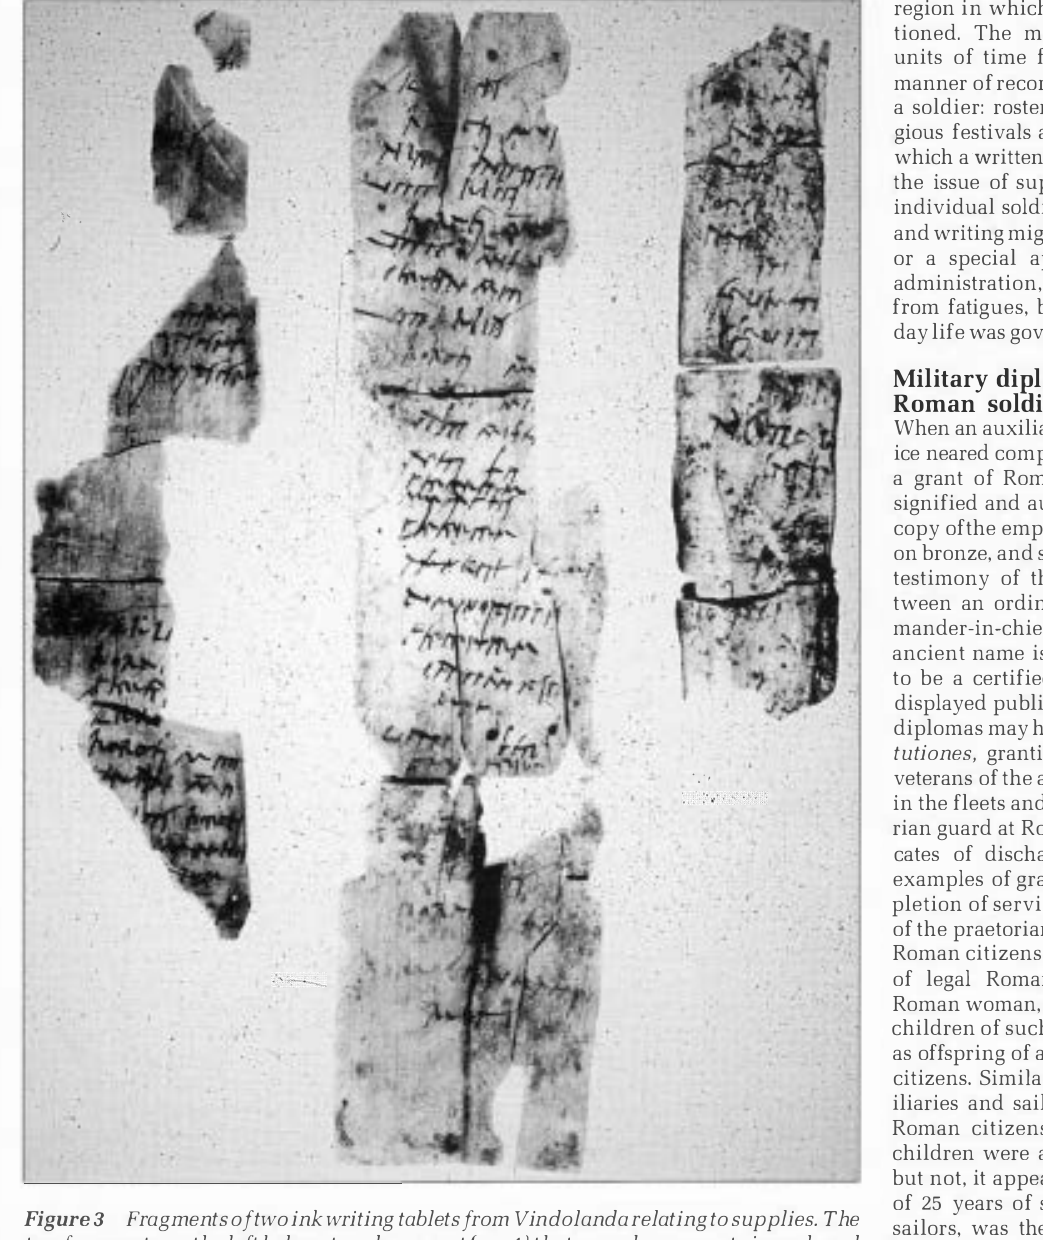
Figure 3 Fragments of two ink writing tablets from Vindolanda relating to supplies. The two fragments on the left belong to a document {no. 4) that records payments in cash and kind and the daily issue of food supplies to military personnel, covering a few days in late June of an unspecified year. That on the right (no. 5) lists purchases of meat (roe­ deer, young pig, ham and venison) and other supplies (spices, salt and wheat}, probably for the Vindolanda garrison. lady added a note in her own hand: "I shall expect you, sister. Farewell sister, my dearest soul, as I hope to prosper,